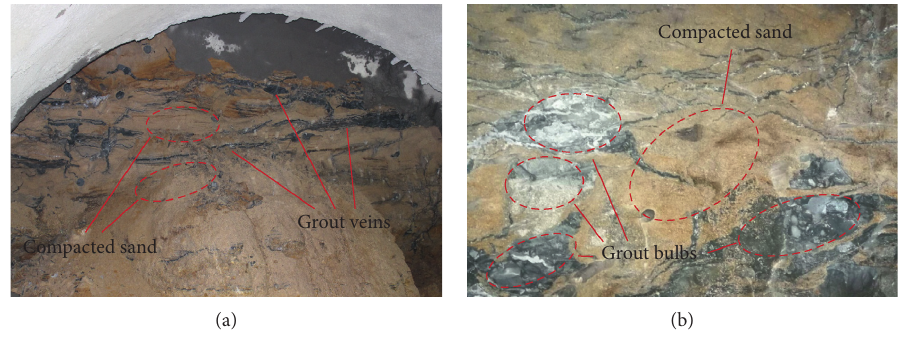
Figure 1: Photos of the grouted body in the sand. (a) Fracture grouting. (b) Compaction grouting.